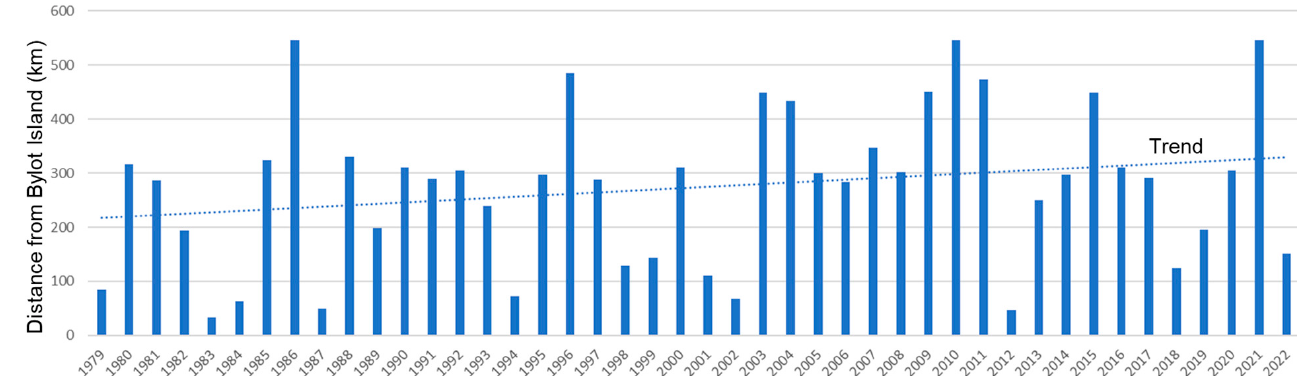
Figure 6. Distance in kilometers from Bylot Island to the Lancaster Sound ice arch for 1979 to 2022. The location of the ice arch is highly variable (R 2 = 0.0548) on an interannual basis, while the overall westward trend of 115 km is statistically weak ( p -value = 0.1262).